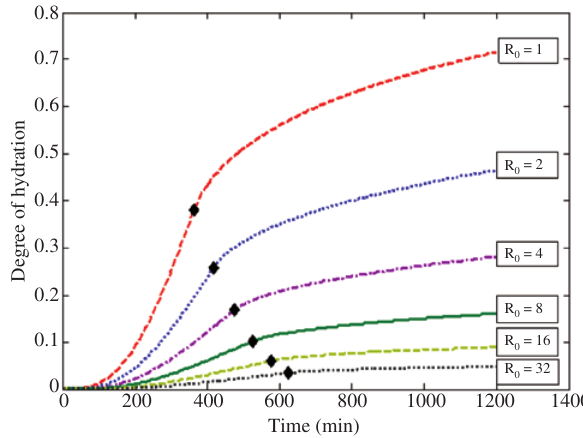
Figure 5 Effect of initial particle size on hydration kinetics of the particles ( R is the initial particle radius in μ m; ♦ indicates the tran- 0 sition point between nucleation and growth and diffusion controlled stages).